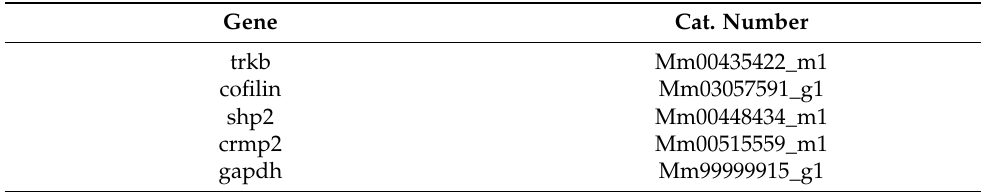
Table 2. List of TaqMan assays (Life Technologies) used in RT–qPCR. Gene Cat.